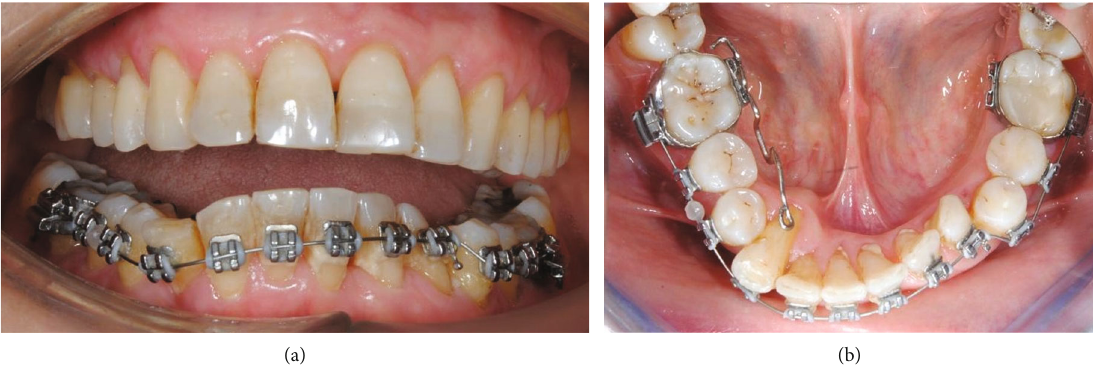
Figure 5: 0.014-in NiTi 3M (a); orthodontic sectional (b).